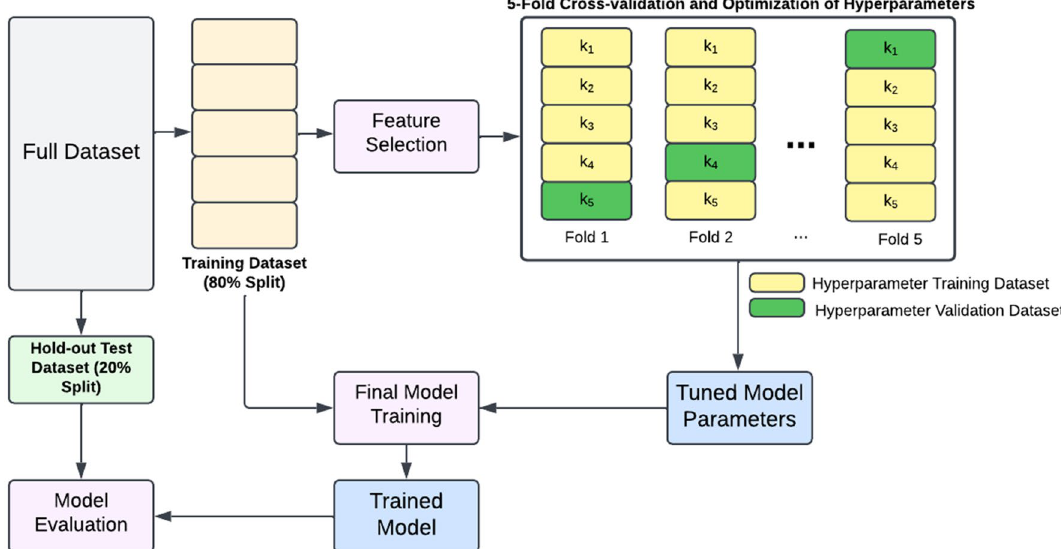
Fig. 3 Model training and evaluation workflow. The training dataset was used for feature selection and optimization of hyperparameters using a fivefold cross-validation method. The tuned model hyperparameters were then used to train the machine learning prediction model with the full training dataset. The trained model was then evaluated on the hold-out test